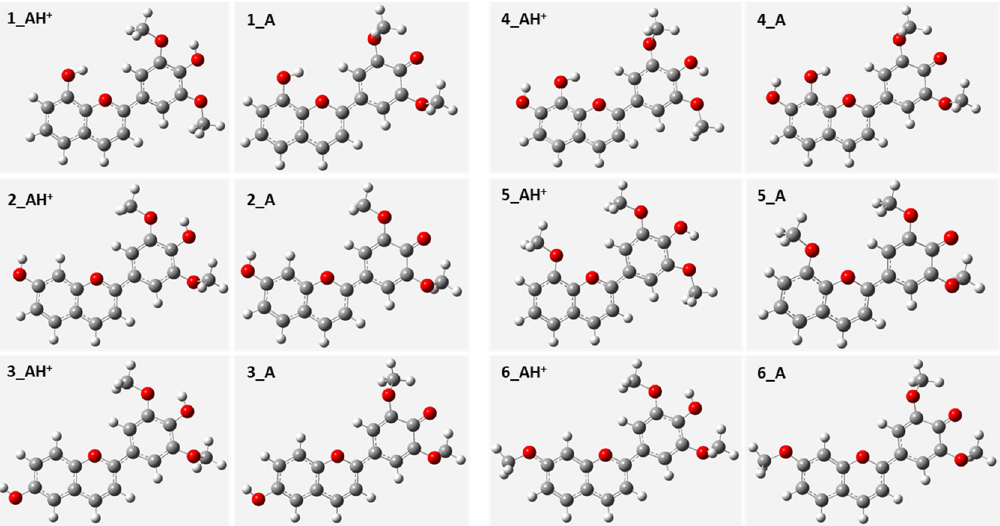
Figure 4. Optimized structures of the dyes (flavylium salts AH + and quinoidal bases A). All investigated dyes, regardless of the specie, flavylium cations or quinoidal bases, present a planar geometry consistent with the extended π conjugation involving the substi- tuted benzopyrylium and the substituted benzene moiety from malvidin (4 (cid:48) -hydroxy-3 (cid:48) , 5 (cid:48)